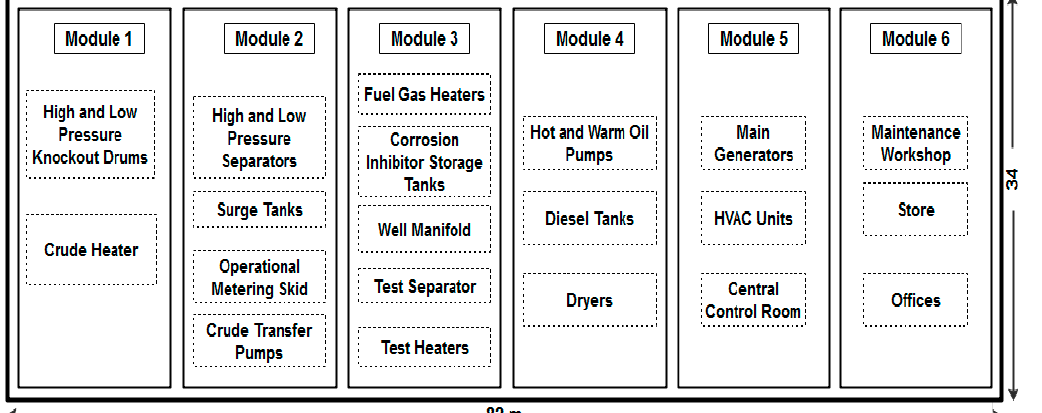
Table 2. (cid:1845) and (cid:1842) (cid:3045) functions with coefficients for all effects ( (cid:1863)) . Effect ( k )